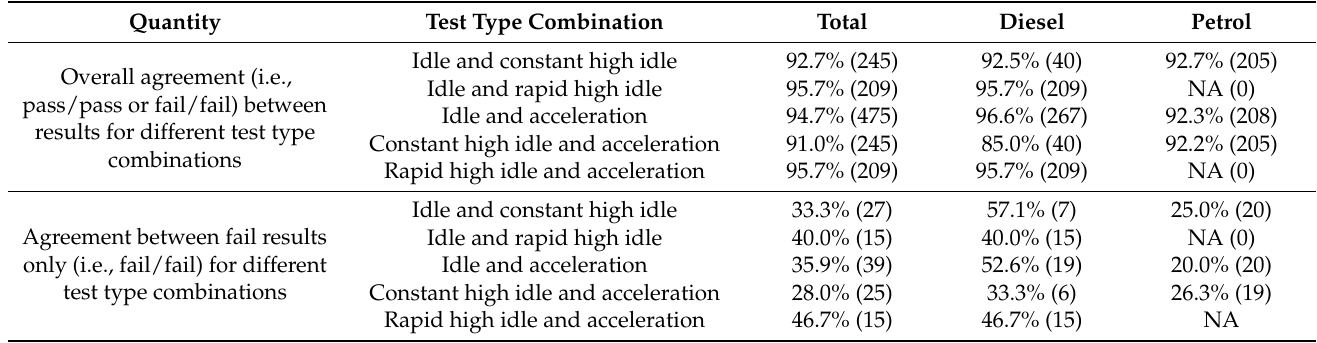
Table 4. Summary of the percentage of agreement between results from different test types for indi- vidual vehicles. Total number of vehicles from which the percentages are calculated are represented in brackets beside each. Top section is for all test results (agreement for passes and fails), whereas the bottom section is only for agreement between vehicle fail results (i.e., if a vehicle fails on one of the test types, the percentage likelihood of it failing on the other test